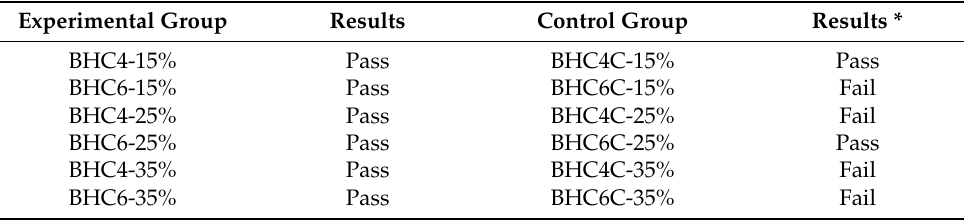
Table 6. Conical mandrel bend test results based on ASTM D552. Experimental Group